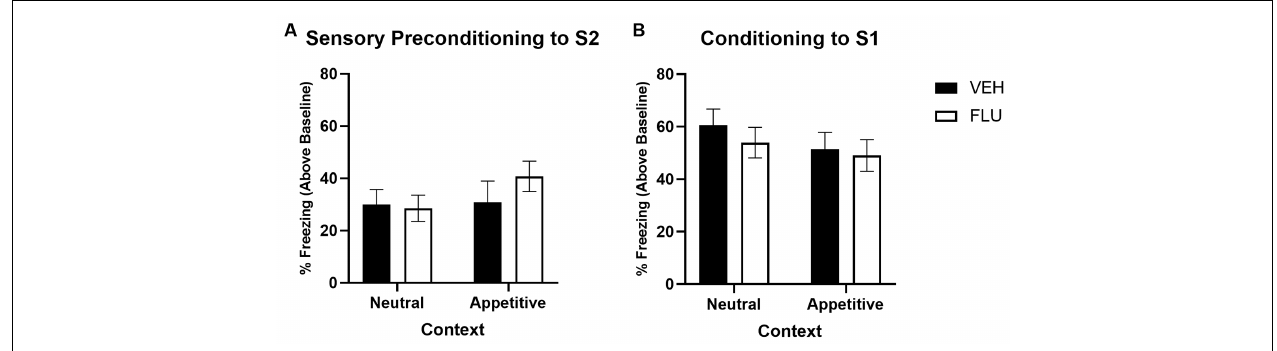
FIGURE 5 | Sensory preconditioning under conditions of non-selective dopamine receptor antagonism when trained in a neutral vs. appetitive context. Panel (A) shows the average per cent time spent freezing in response to S2 (stimulus—baseline) on the test of sensory preconditioning for groups in the Neutral vs. Appetitive context condition. Panel (B) shows the average per cent time spent freezing to S1 (stimulus—baseline) on the test of first-order conditioning for groups in the Neutral vs. Appetitive context condition. Black bars indicate groups treated with saline vehicle (VEH; Neutral condition n = 16, Appetitive condition n = 12), and white bars indicate groups treated with α -flupenthixol (FLU; Neutral condition n = 16; Appetitive condition n = 12). Error bars represent ±